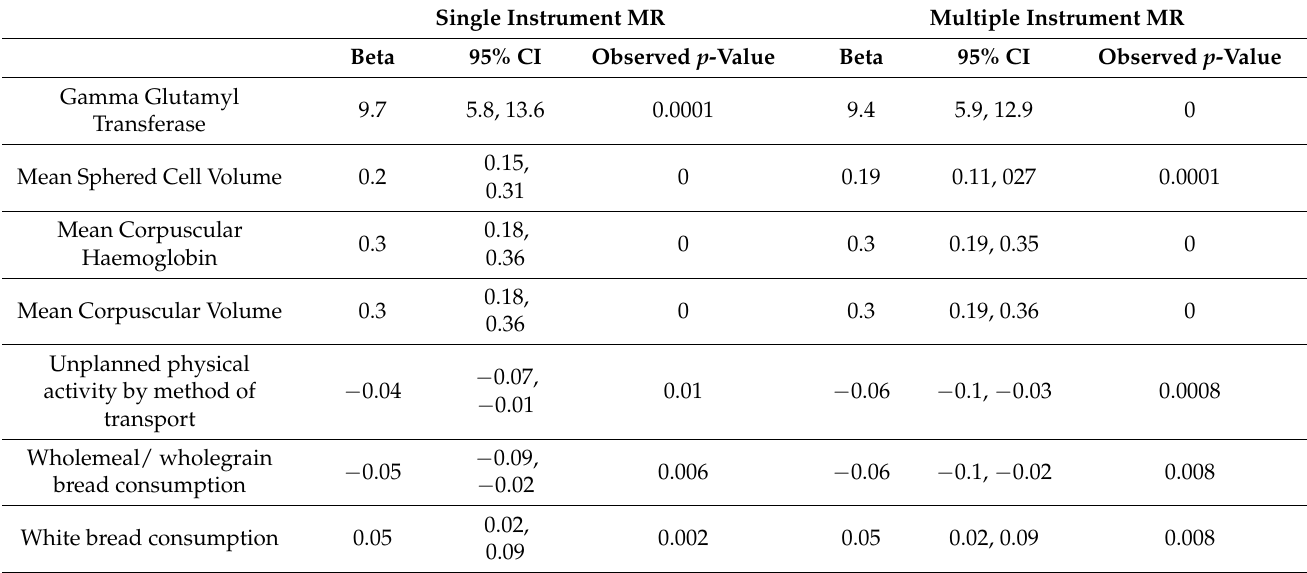
Table 2. Overview of the results of Mendelian Randomisation analysis.